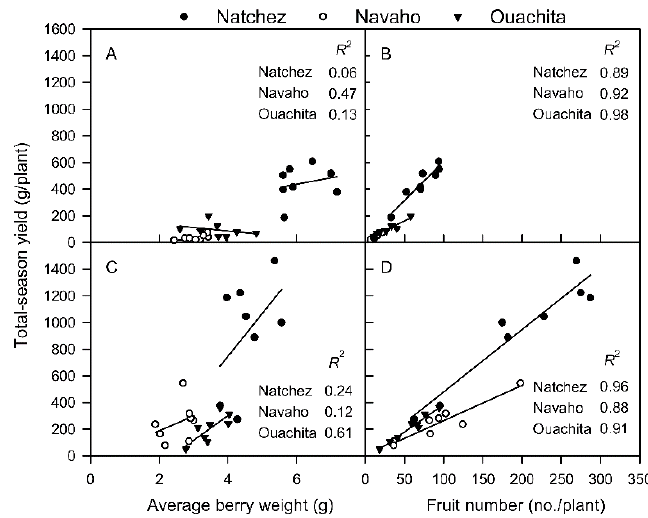
Figure 2. Linear correlation between average berry weight or fruit number and total-season yield of ‘Natchez’, ‘Navaho’, and ‘Ouachita’ blackberry grown under subtropical climatic conditions in the 2015–2016 season ( A , B ) and the 2016–2017 seasons ( C , D ). Plants were treated with gibberellic acid (GA 3 ) at 0 or 49 g·ha − 1 (53 mg·L − 1 ) via spray application with a spray volume of 935 L·ha − 1 on 24 December 2015 in the 2015–2016 season and on 27 January 2017 in the 2016–2017 season.